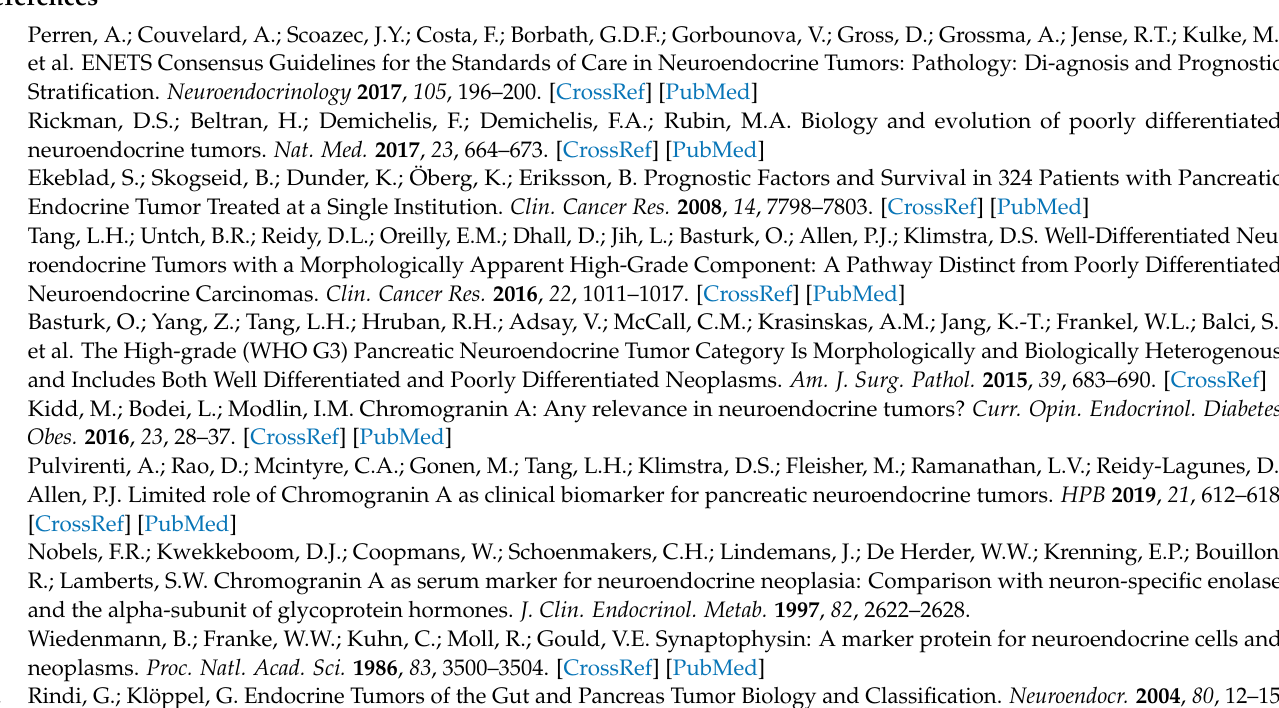
Figure S2. Association of pSyn and platelet activation. Figure S3. Expression of pSyn in NEN patients showing a disease relapse. Table S1. Clinical characteristics of the NEN screening cohort